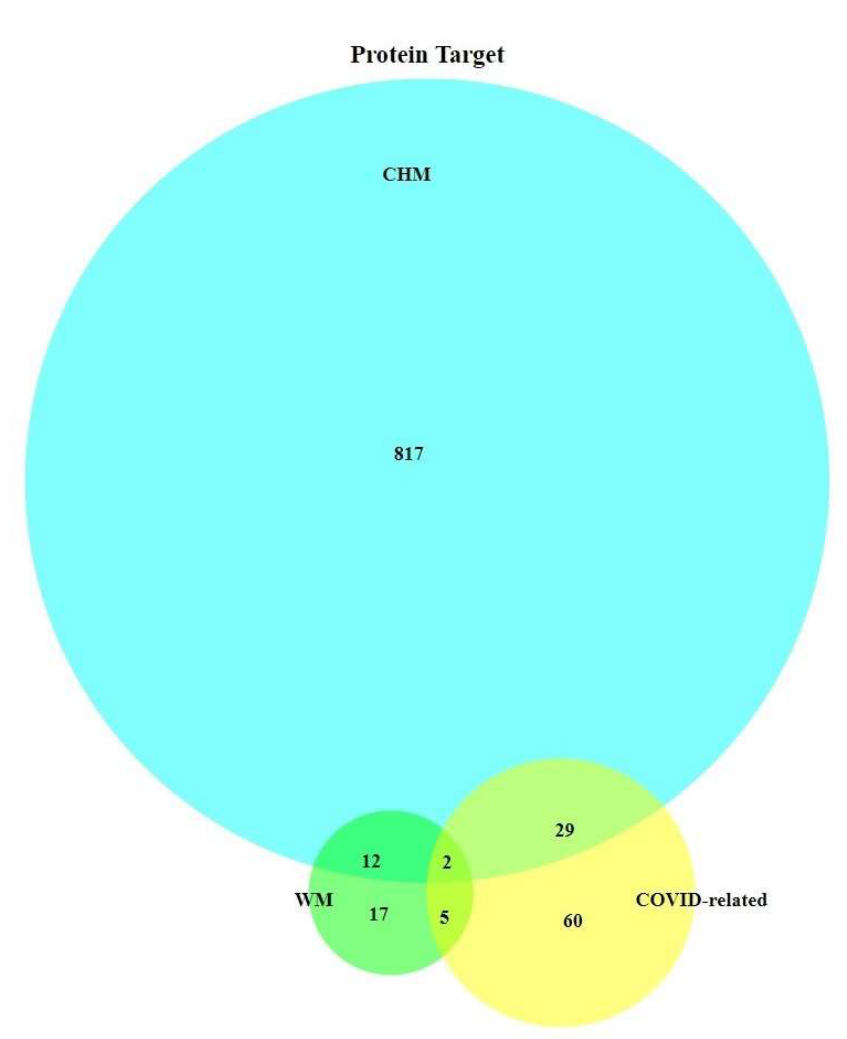
Figure 2. Venn diagram of protein